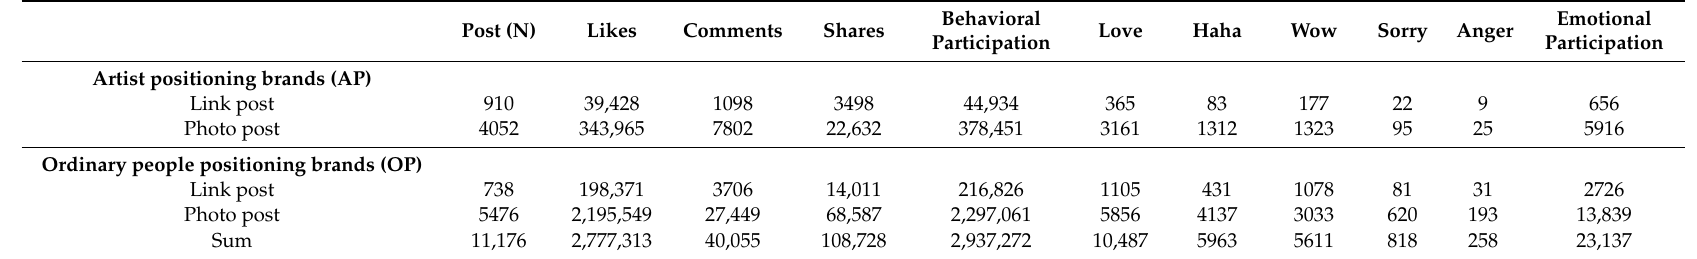
Table 1. Total number of